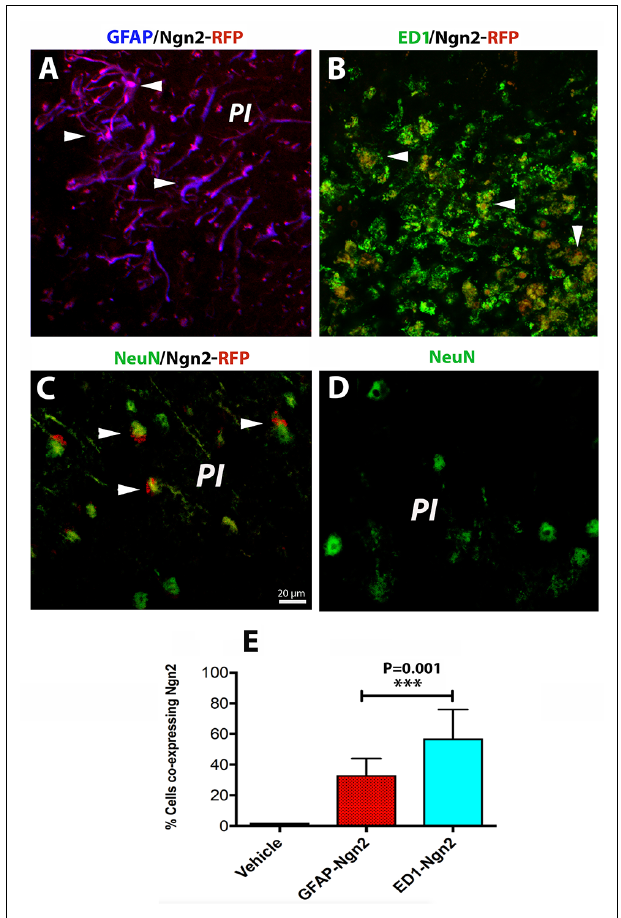
FIGURE 3 | In the aged, post-stroke brains of the transgenic mice, astroglia was highly proliferative (A) . In the aged brains at day 3 after stroke ( N = 5 mice), the fraction of infected astrocytes in the peri-infarcted with the retrovirus carrying the Ngn2-RFP sequence was high (57%) in the aged brain (E) . At the same time point, the number of ED1-RFP co-labeled cells was 33% ( B , arrow heads; E ). At day 28, in the lesioned brains of aged post-stroke transgenic mice displaying GFP-neurons, we found indeed a large number of co-labeled Ngn2-RFP/NeuN-GFP cells. However, a closer examination of their nuclei revealed that Ngn2-RFP expression was confined to the NeuN-GFP-labeled neuronal nuclei ( C , arrowheads). Animals treated with the vehicle ( N = 3) showed NeuN-GFP neuronal nuclei only (D) . Scale bar, 20 µ m. ∗∗∗ P < 0.001, by one-way ANOVA with Tukey’s post hoc test for multiple group